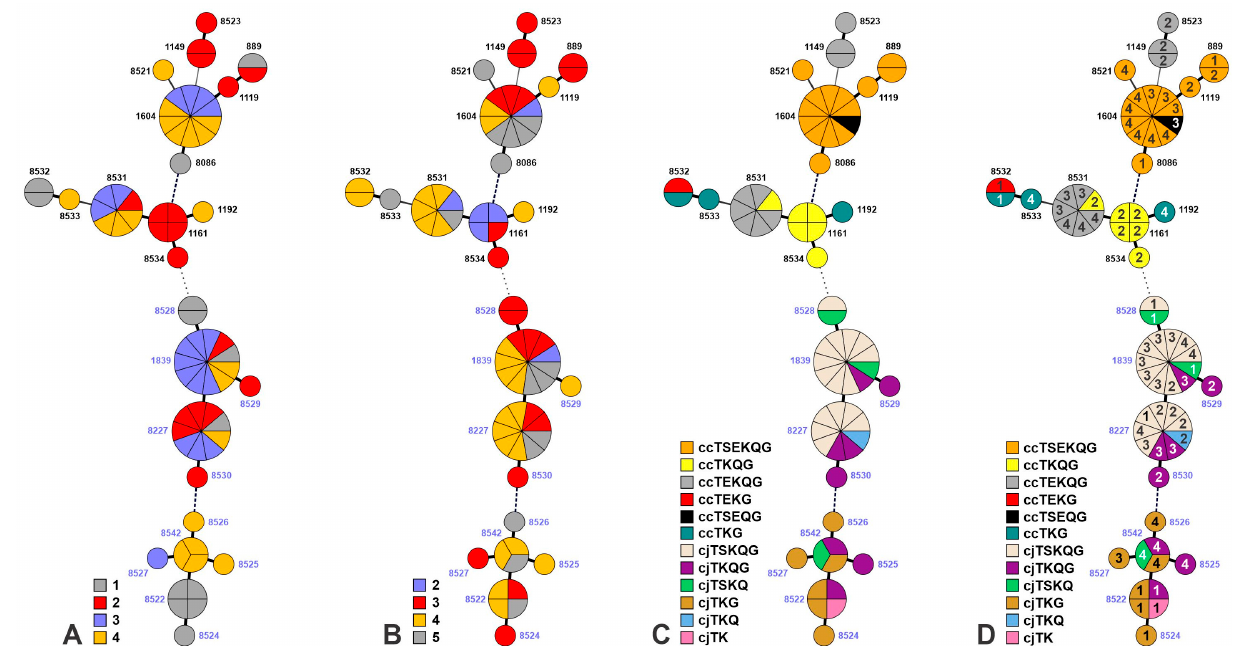
Figure 2. Minimum spanning tree of the Campylobacter MLST sequence types. Minimum spanning tree showing the clustering of the MLST-based STs of 69 C. coli and C. jejuni isolates. Each tree is colored based on ( A ) flock, ( B ) week, ( C ) AMR profile, or ( D ) AMR profile by color and flock by number. The tree was created in BioNumerics (v. 7.6). Each ST is represented by a circle with each segment in the circle corresponding to an individual isolate. Sequence types in blue font are C. jejuni while those in black font are C. coli . Thick short lines connecting STs indicate single-locus differences; thin lines indicate two-locus differences; a longer, thinner line indicates a three-locus difference; and black dotted lines represent > four-allele differences. The gray dotted line between STs 8528 and 8534 separates C. jejuni STs in the bottom (blue font STs) from C. coli STs in the top (black font STs). Table 3. Campylobacter jejuni and C. coli sequence types identified in the four turkey flocks.